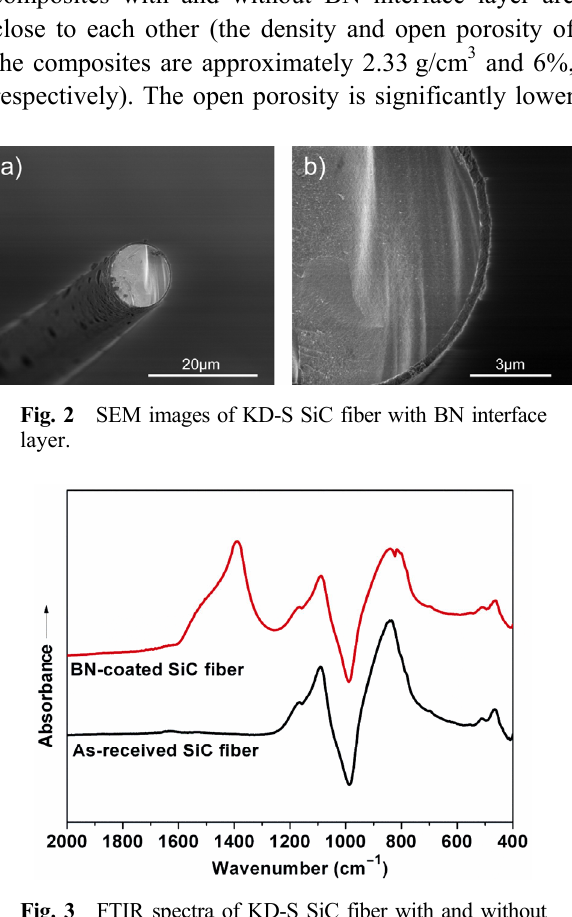
Fig. 3 FTIR spectra of KD-S SiC fiber with and without BN interface